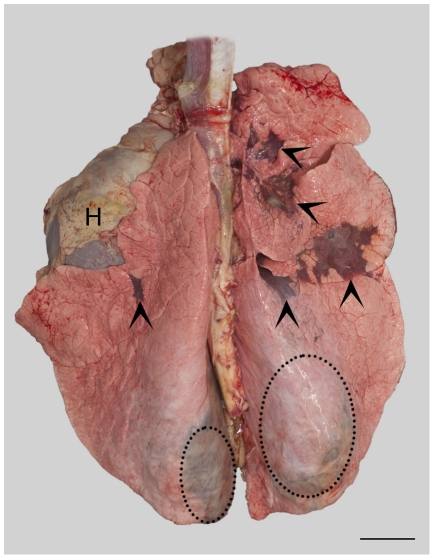
Distribution and extent of pulmonary lesions at day 3 pi in a calf inoculated with 109 ifu of C. psittaci.Dorsal view of the lung and heart (H). Pneumonic lesions present as dark red discolorations (>) in the apical lobes, middle lobe and basal lobes. Note distension of the basal lobes due to severe bronchopneumonia in the inferior segments (hatched lines). Bar = 5 cm.